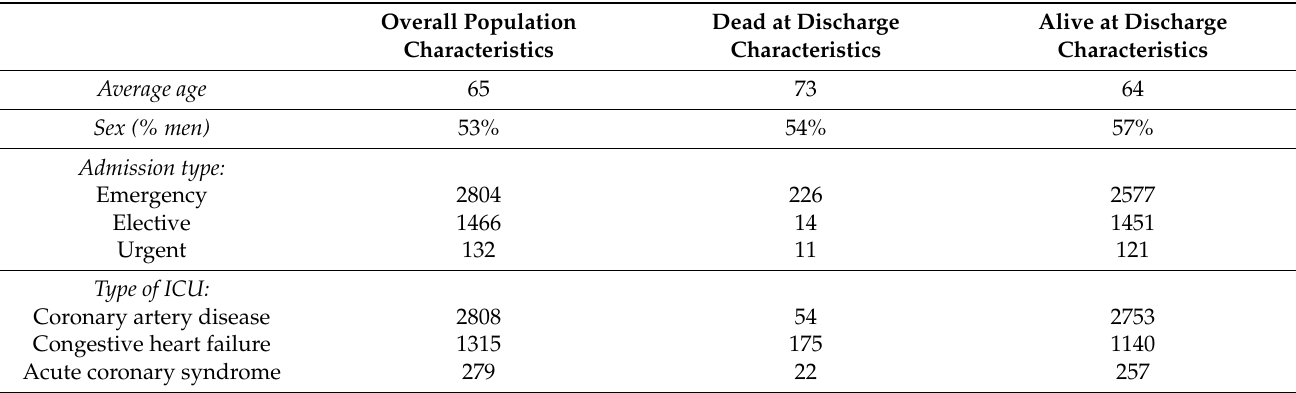
Figure 2. MIMIC III dataset generation process. Table 1. Baseline patients’ characteristics and outcome